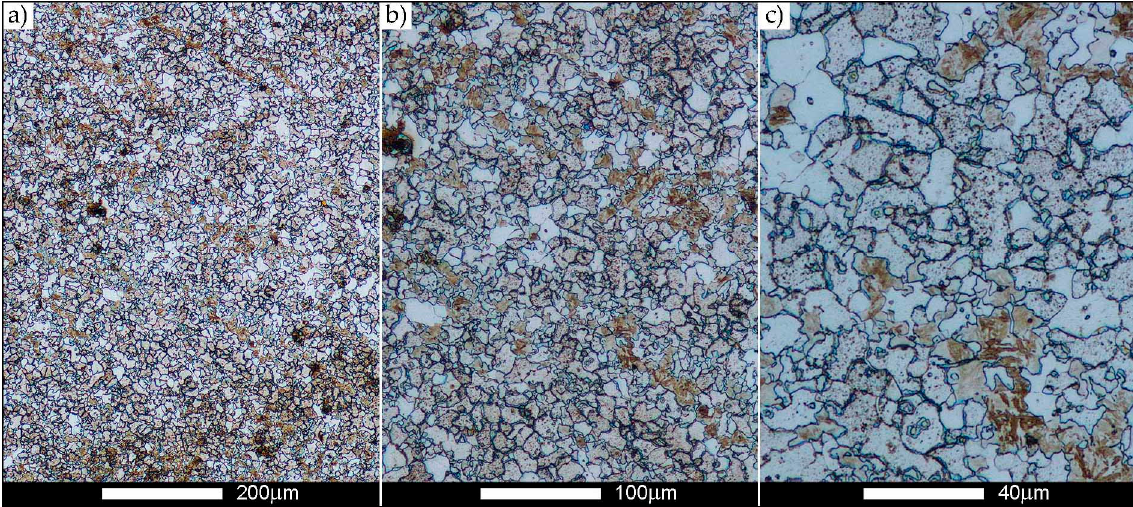
Figure 31. Welded joint microstructure of Hardox 450 steel with exposed grain boundaries of prior austenite, austenitised at 900 °C—WM1 zone shown in Figure 2. ( a ) 100×; ( b ) 200×; ( c ) 500×.